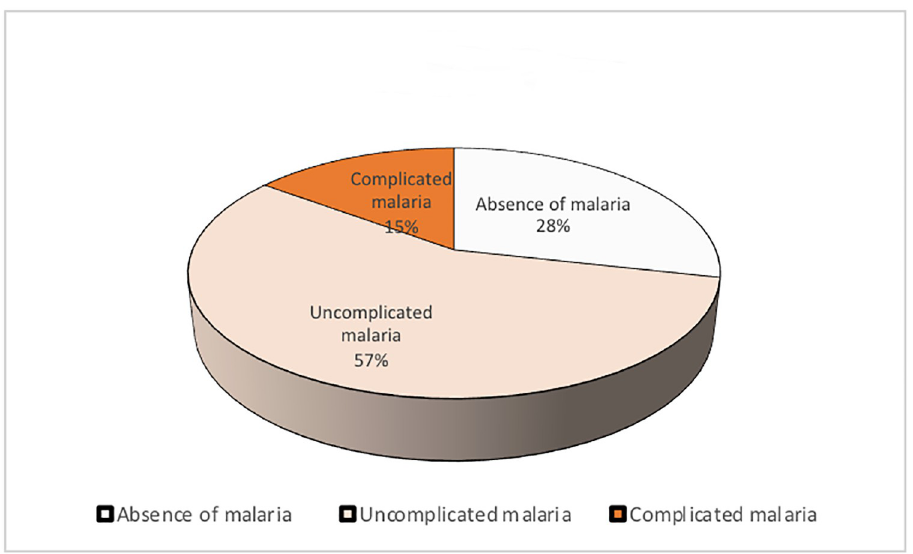
Fig 1. Distribution of malaria during the pregnancy in study